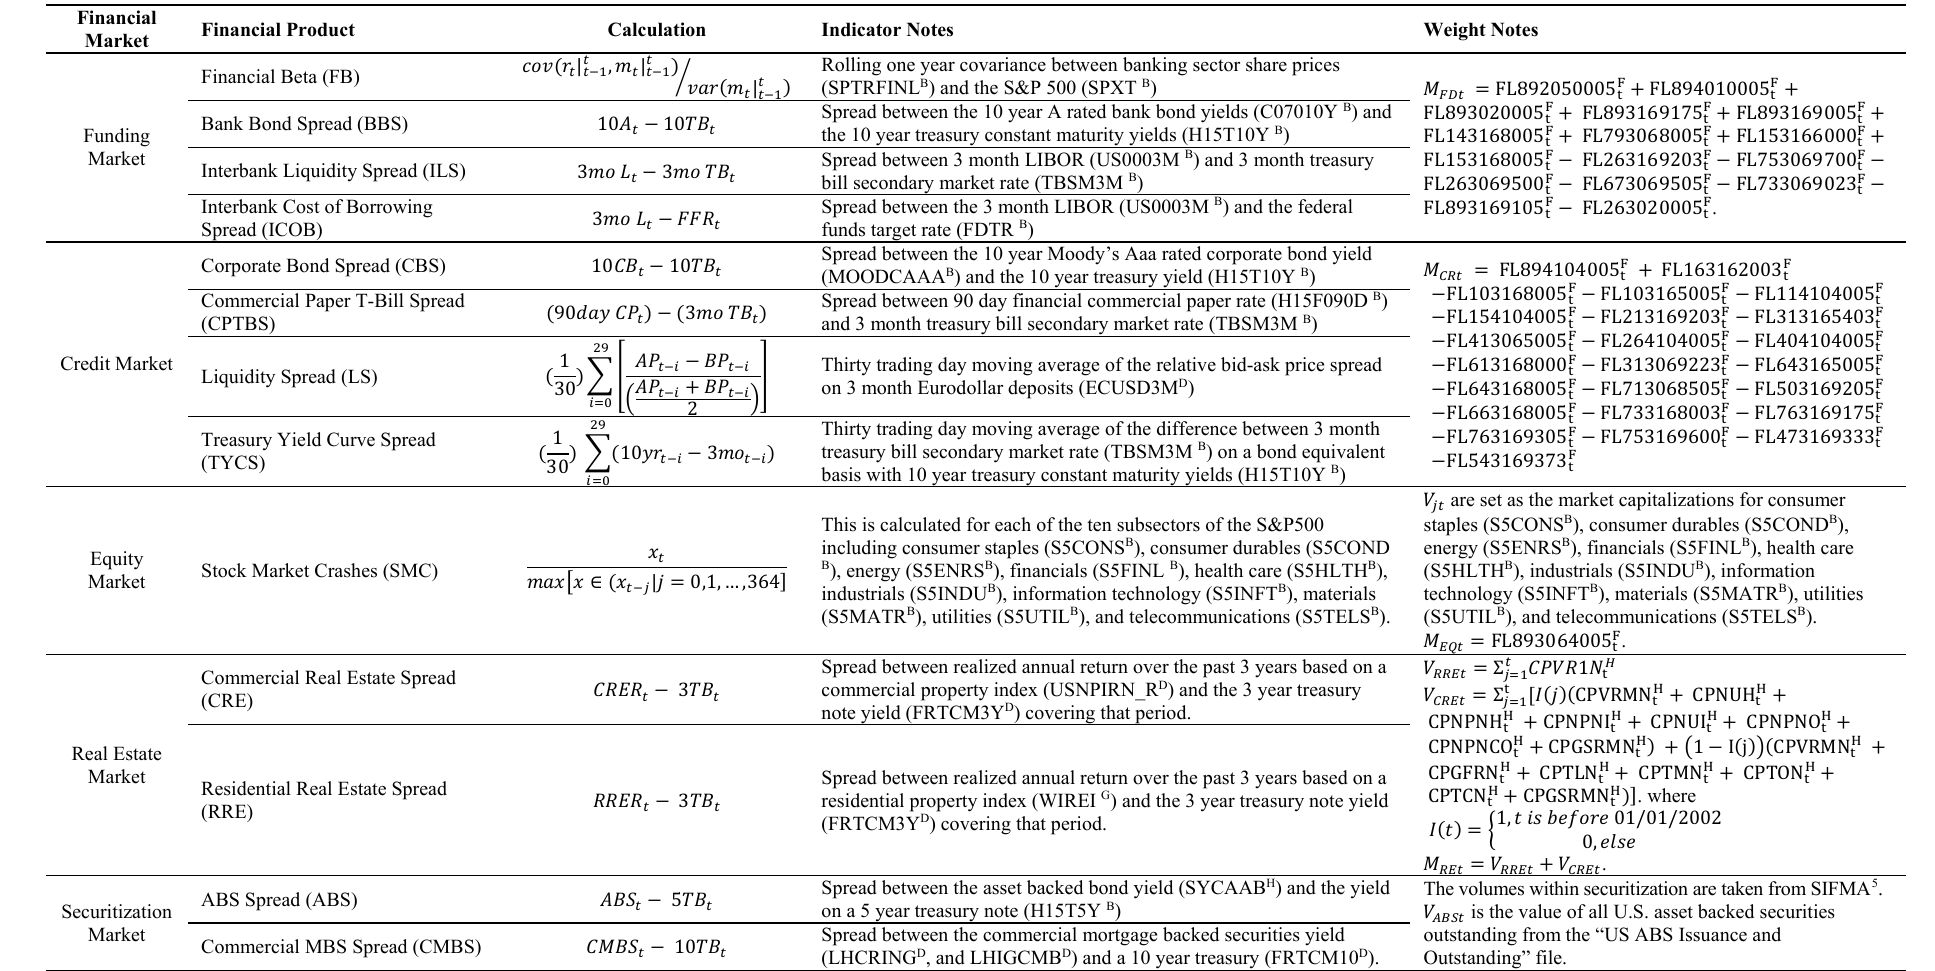
Table 1. Financial stress index